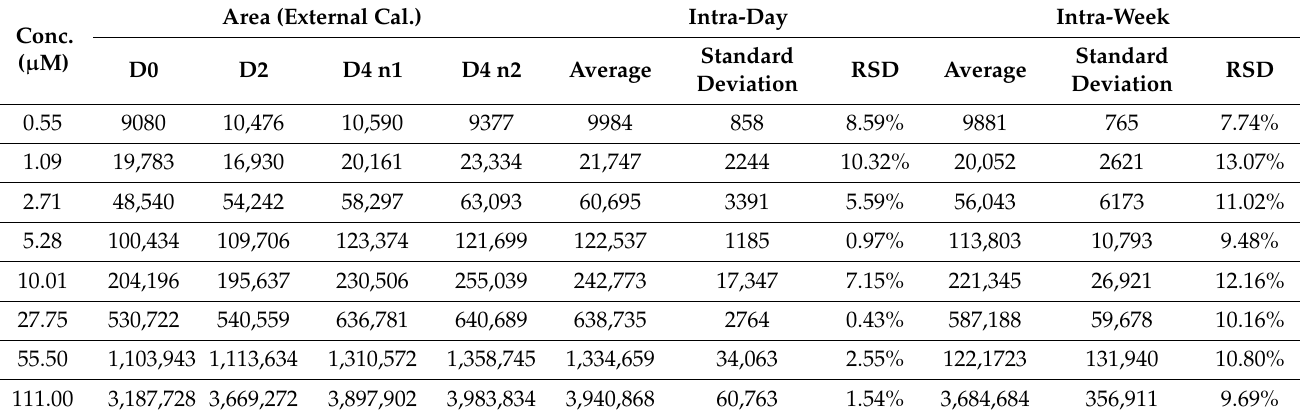
Table 5. Intra-day assay and intra-week (day 0, 2, and 4) precision of calibration curve of T6P.